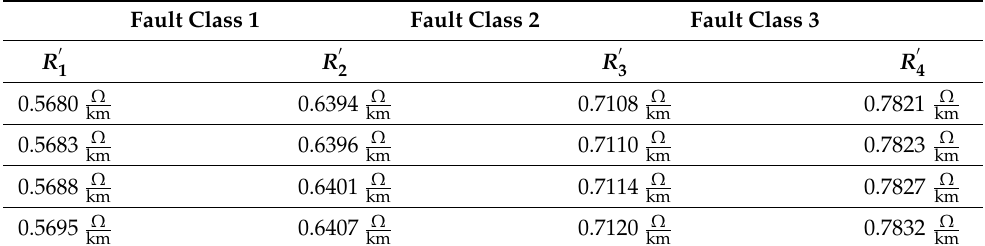
Table 5. Fault classes based on resistance value.